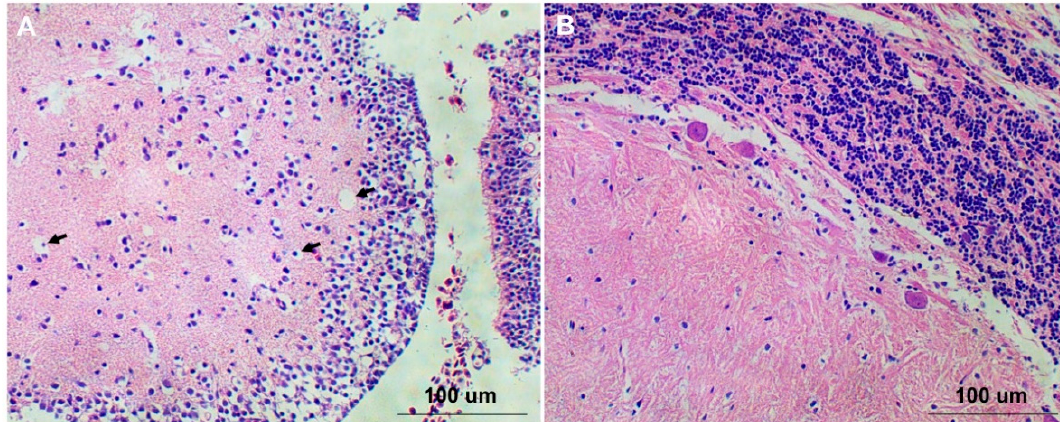
Figure 4. ( A ) The brain tissue of RGNNV-infected Mandarin fish. Black arrows pointed to vacuoles; ( B ) The brain tissue of mock-infected Mandarin fish.